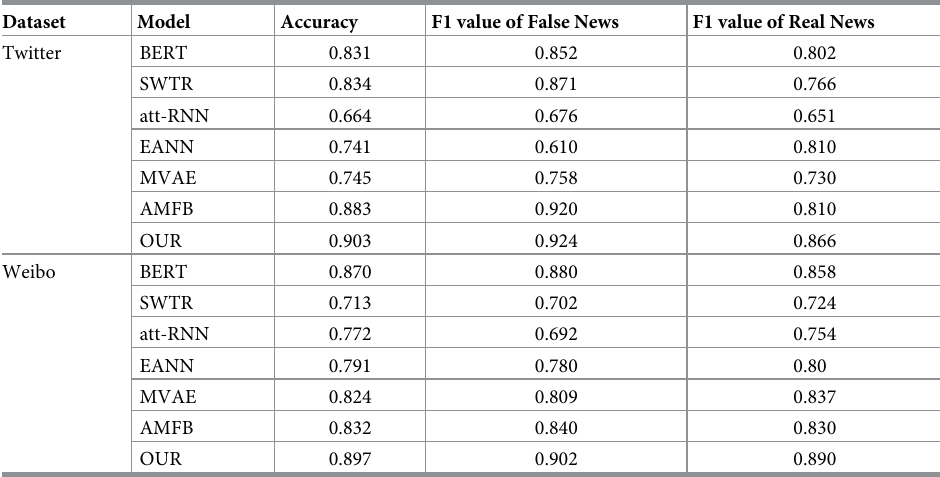
Table 3. Comparative results for the Weibo and Twitter